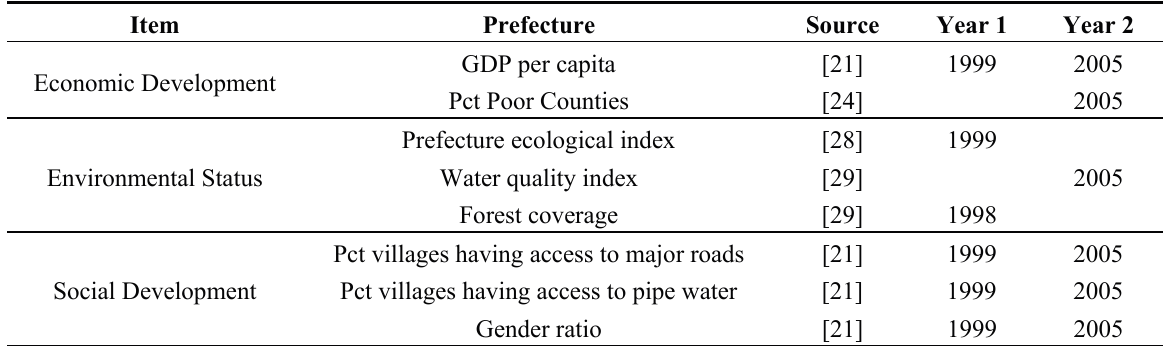
Table 1. Indicators of economic development, environmental status and social